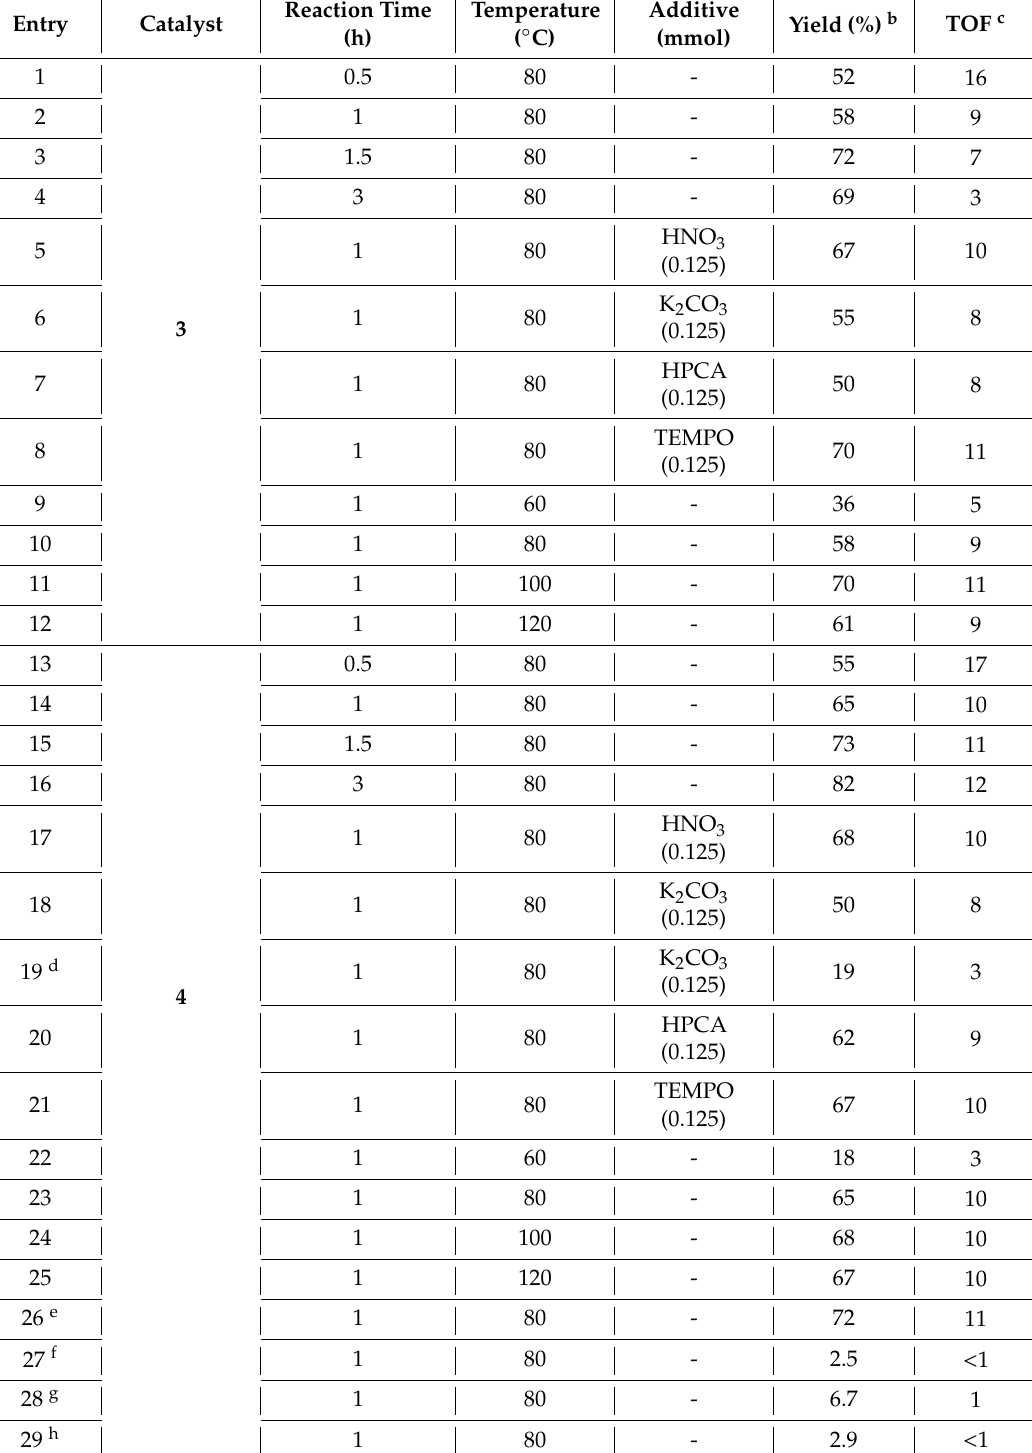
Table 3. MW-assisted solvent-free oxidation of 1-phenylethanol to acetophenone by 3 and 4 .